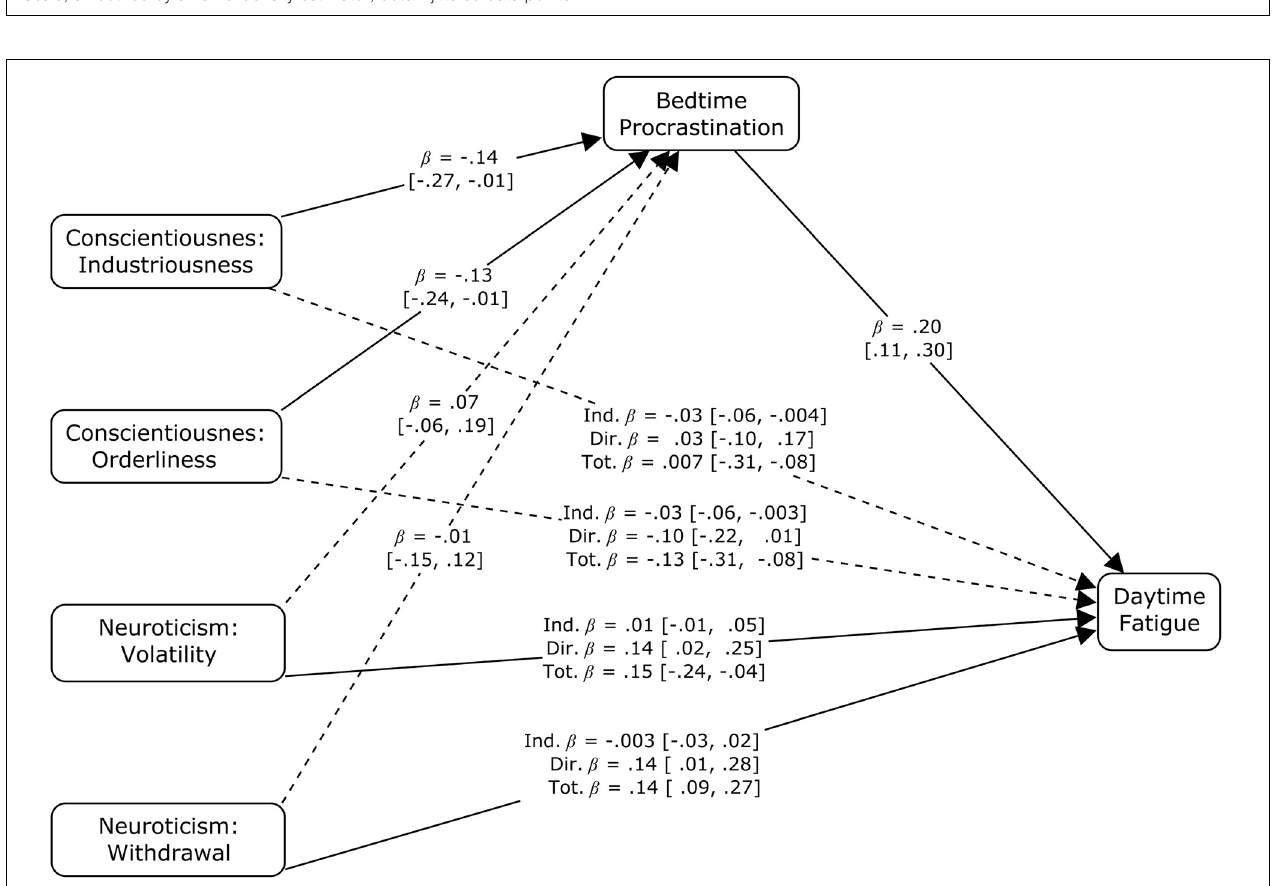
FIGURE 3 | Standardized parameter estimates for indirect, direct, and total effects of the aspects of Conscientiousness and Neuroticism on self-reported average frequency of daytime fatigue with bedtime procrastination as a mediating variable. β – standardized estimate with the limits of bootstrapped 95% confidence intervals [given in brackets]; solid arrows – significant components of indirect effects or significant direct effects; dotted arrows – insignificant components of indirect effects or insignificant direct effects.